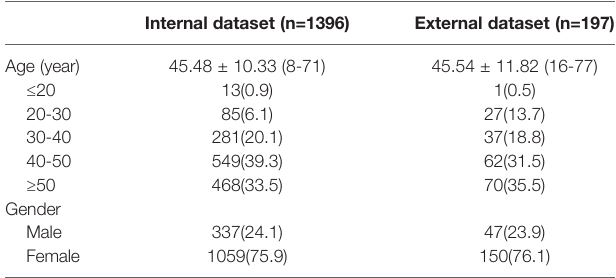
TABLE 1 | Basic information of the patients.